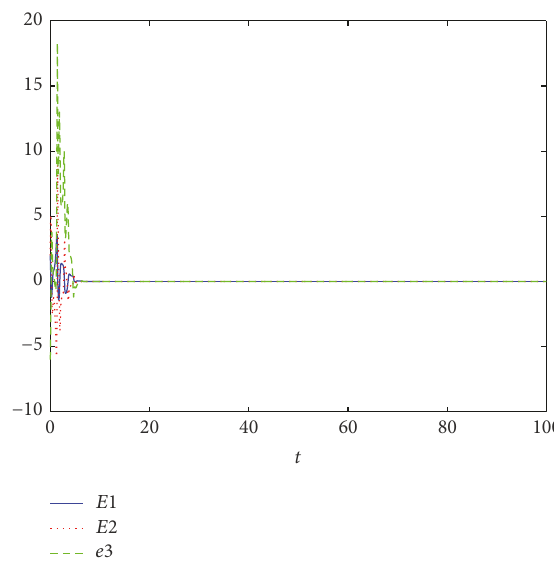
Figure 6: Get the error system asymptotically stable with controller = (0,𝑝 𝐸 ,0) 𝑇 . 𝑈 3 2 2